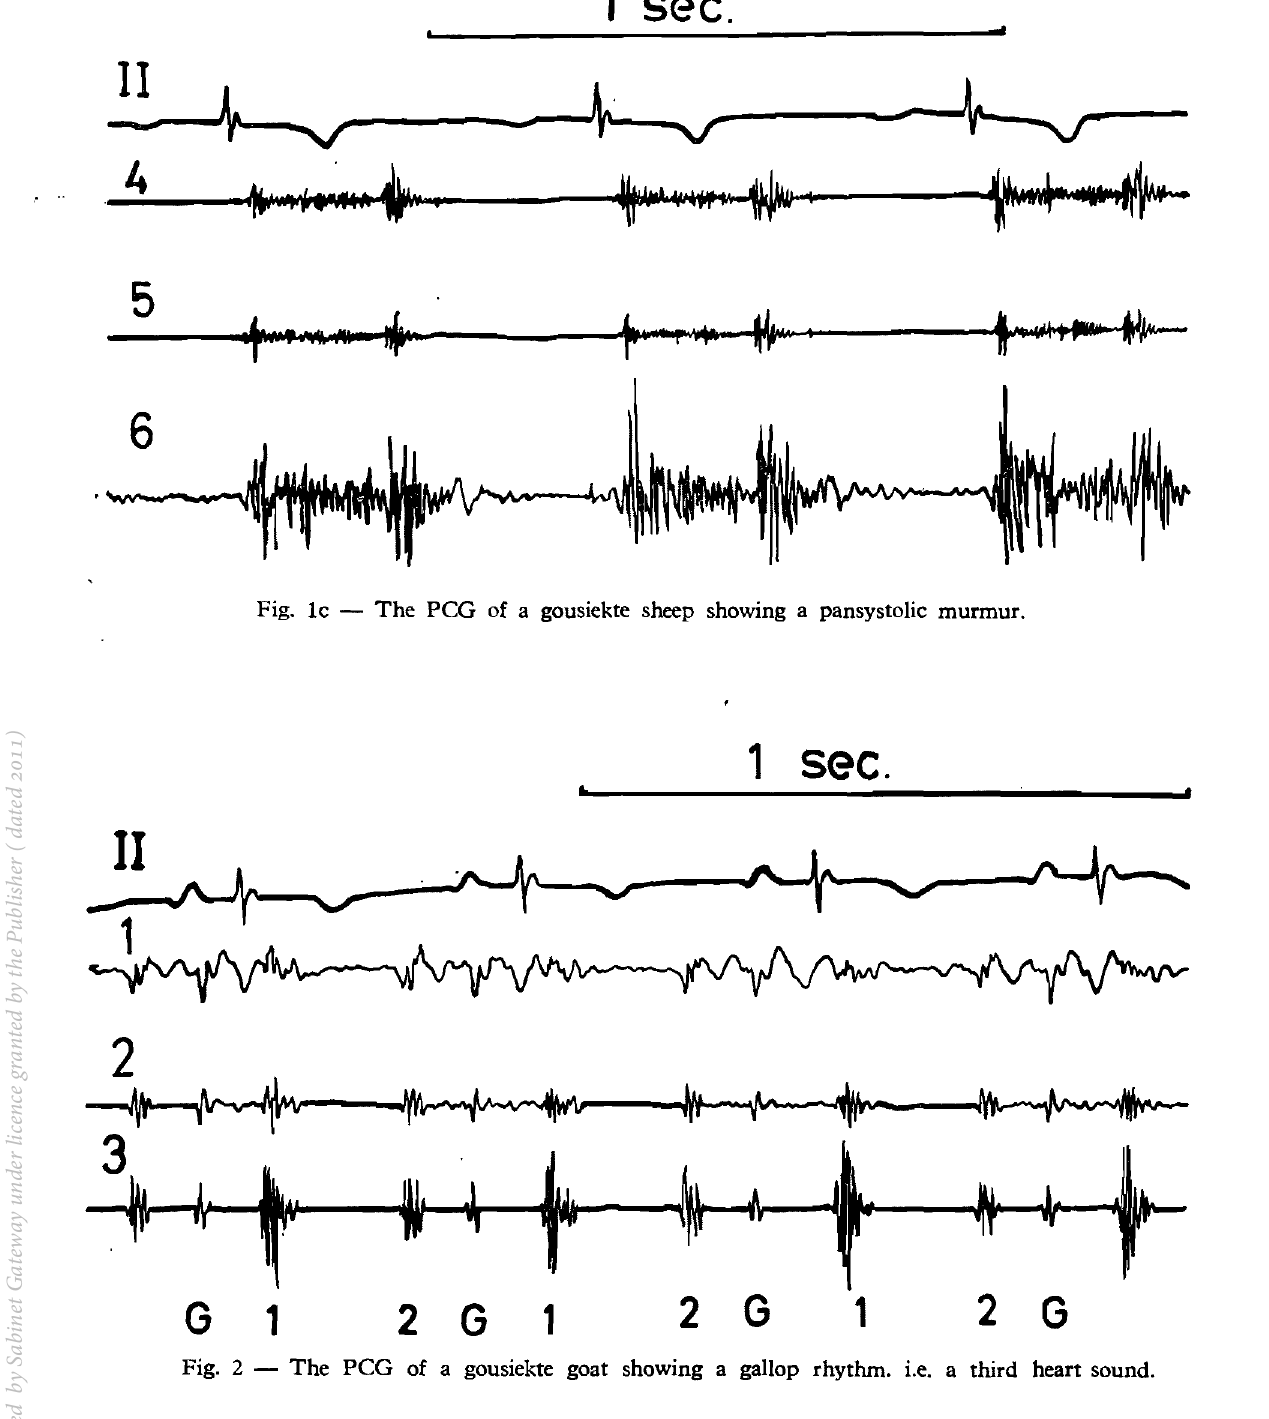
Fig. 2 - The PCG of a gousiekte goat showing a gallop rhythm. i.e. a third heart sound.